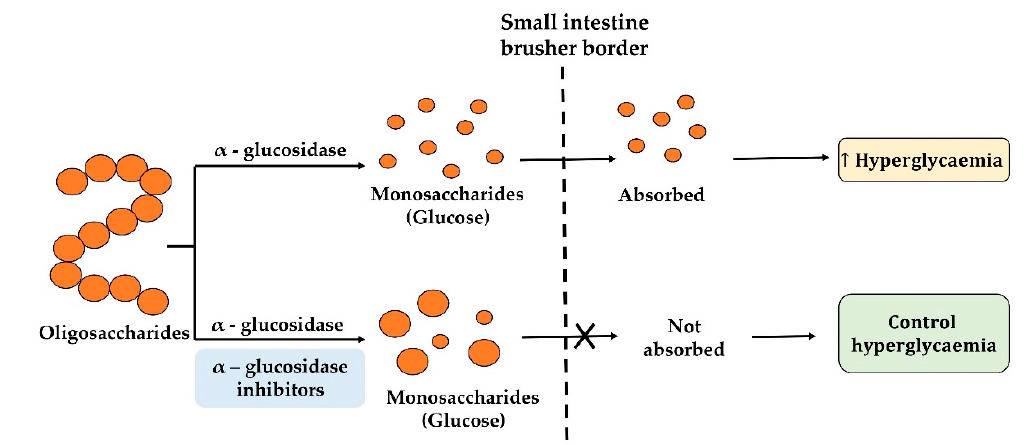
Figure 2. Mechanism of action of alpha-glucosidase inhibitors.